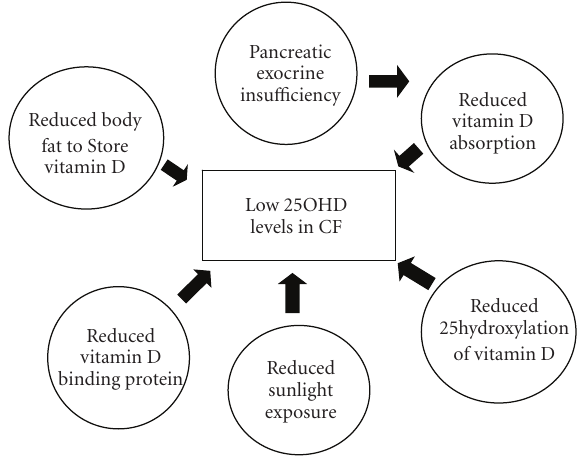
Figure 1: Causes of Vitamin D insu ffi ciency in CF Patients [11].